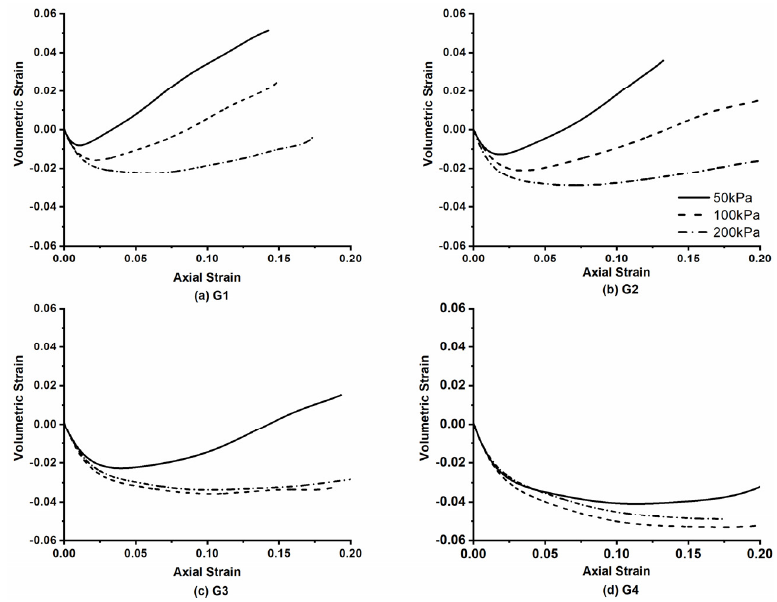
Figure 5. Volumetric strain versus axial strain for TDA ‐ gravel mixtures with 5%, 10%, 20%, and 30% TDA by weight at confining pressures of 50 kPa, 100 kPa, and 200 kPa.